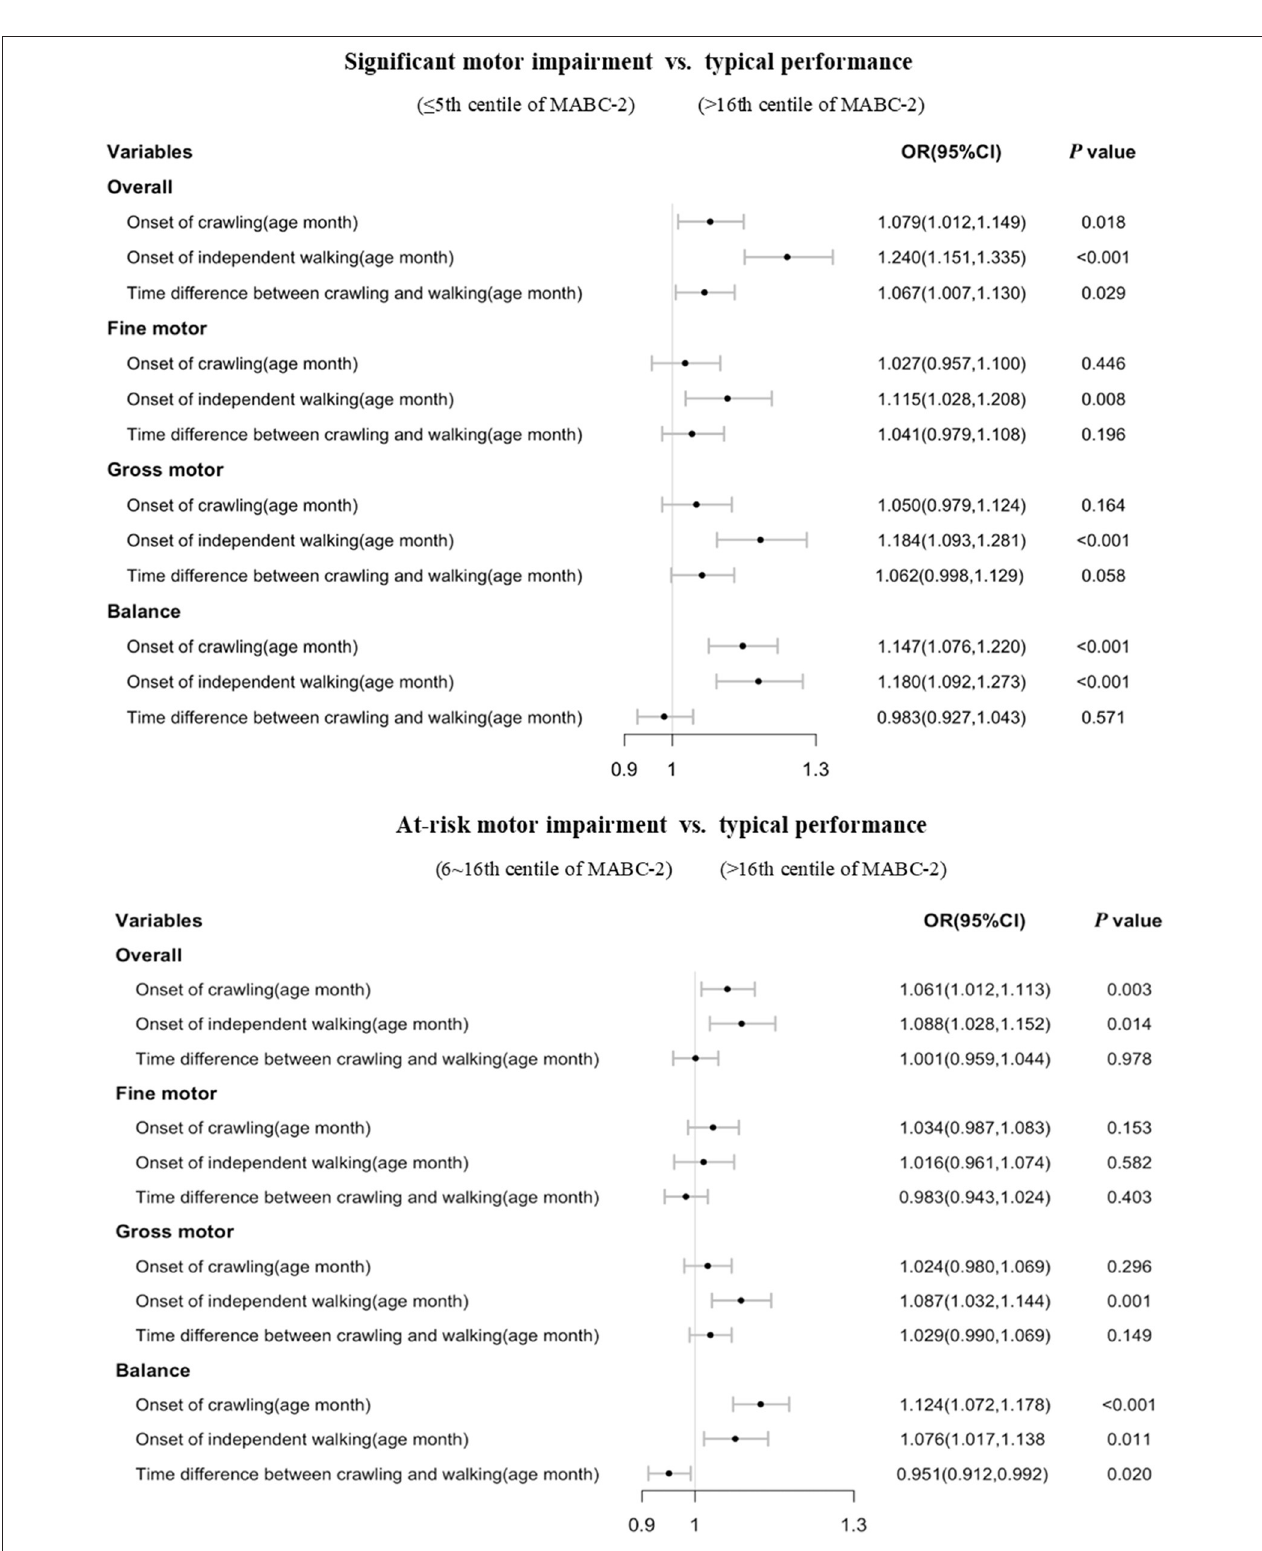
FIGURE 3 | Association of walking and crawling during infancy with DCD by different age group in children aged 5–6 years old ( n = 4,926).